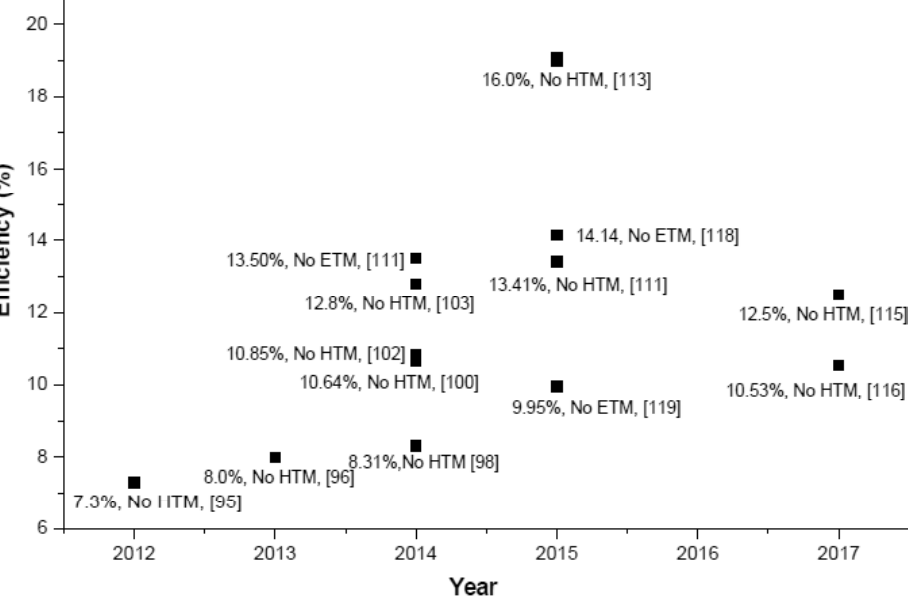
Fig. 4. Progress in efficiency of HTM/ETM free perovskite solar